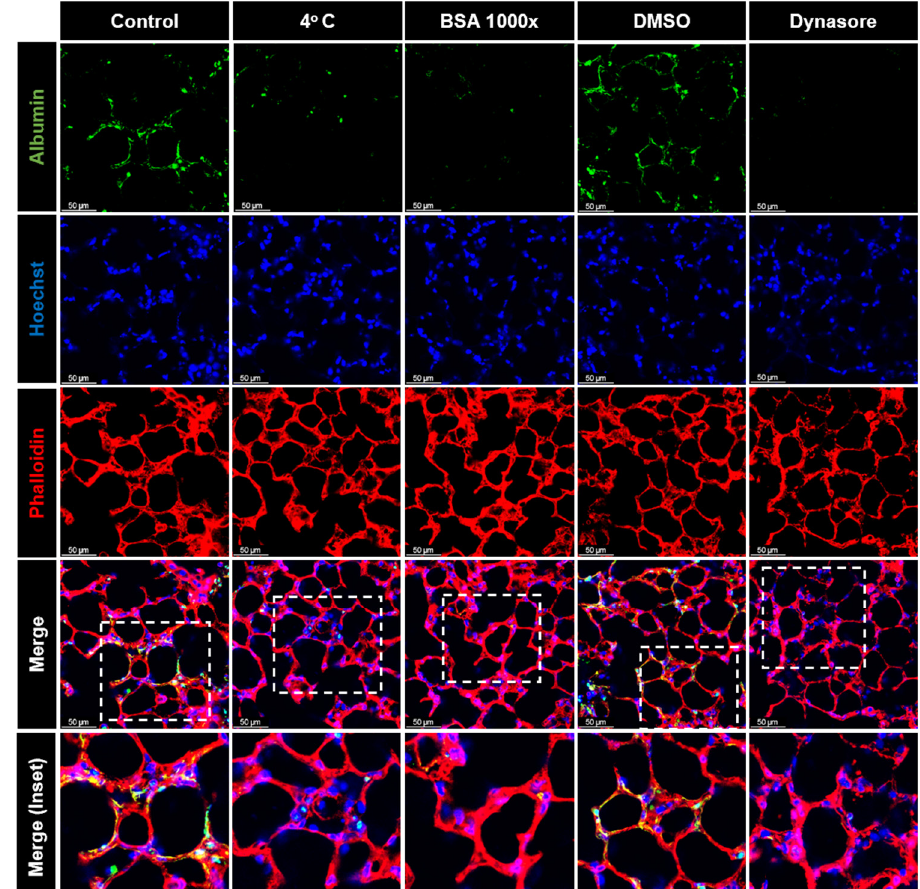
Figure 3. Mechanism of the albumin uptake in PCLS: murine PCLS were treated with AlexaFluor488- albumin for 60 min at 37 ◦ C (control), 4 ◦ C, in the presence of 1000-fold excess of bovine serum albumin (BSA), or with dynasore (or vehicle (DMSO)), and were then analyzed by confocal microscopy. Repre- sentative fluorescence images in murine PCLS are shown. Albumin (green), phalloidin (red), and nuclei (blue) are shown. The dashed line boxes mark the insets. The arrows show the co − localization of albumin and phalloidin. Scale bar − 50 µ